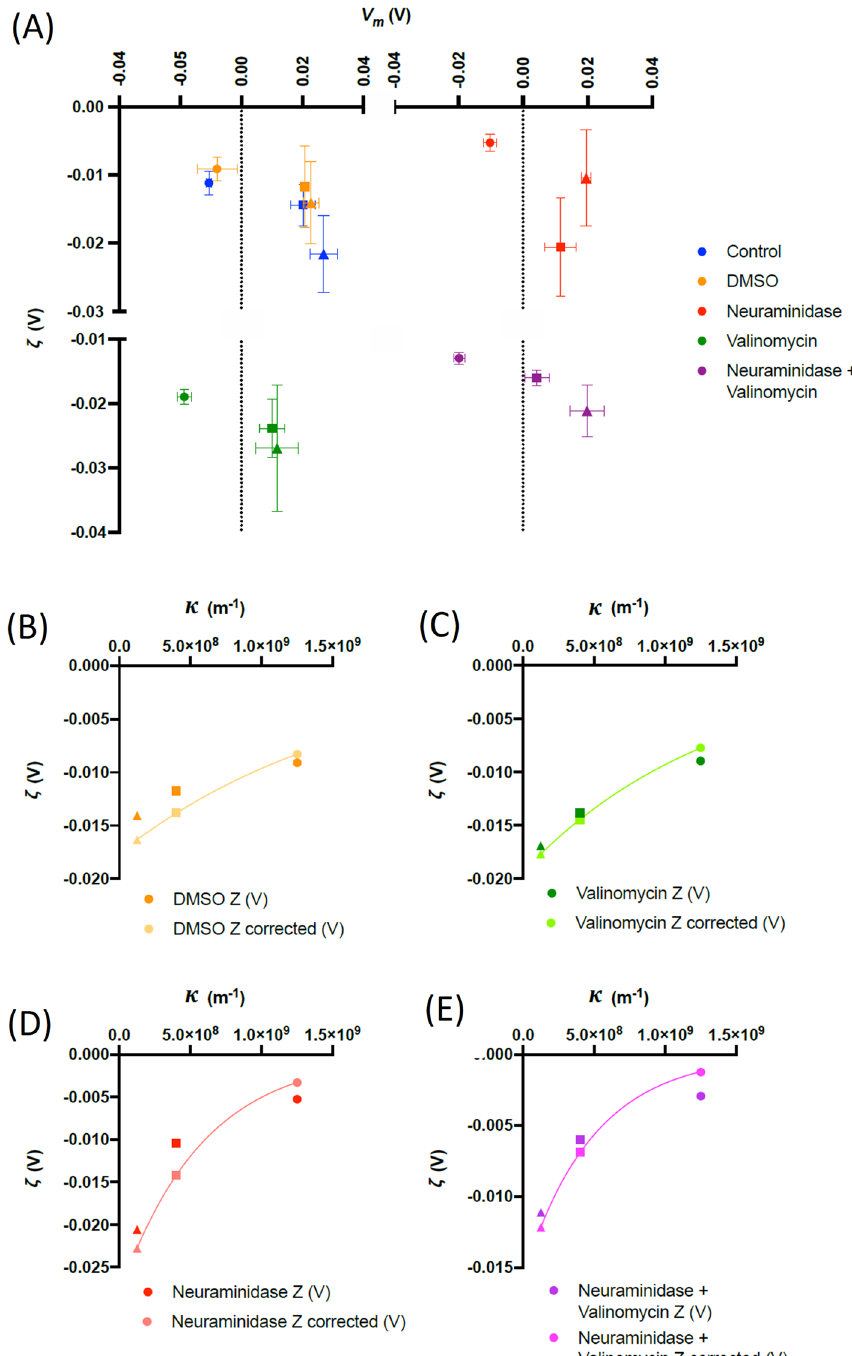
Figure 4. ( A ) The mean variation (± s.d.) in V m and ζ for RBCs suspended in media containing 100% (square), 10% (circle) and 1% (triangle) physiological saline as described in the text. RBCs were treated with valinomycin, neuraminidase, and a combination of both, as well as a DMSO was control. All points represent the average of four donors. ( B – E ) The values of ζ from Fig. 4A plotted against the reciprocal Debye length κ , together with values adjusted by ΞV m as described in the text. The relationship between these variables theoretically follows a negative exponential, to which the adjusted values offer a perfect (R 2 = 1) fit. All points represent the average of four